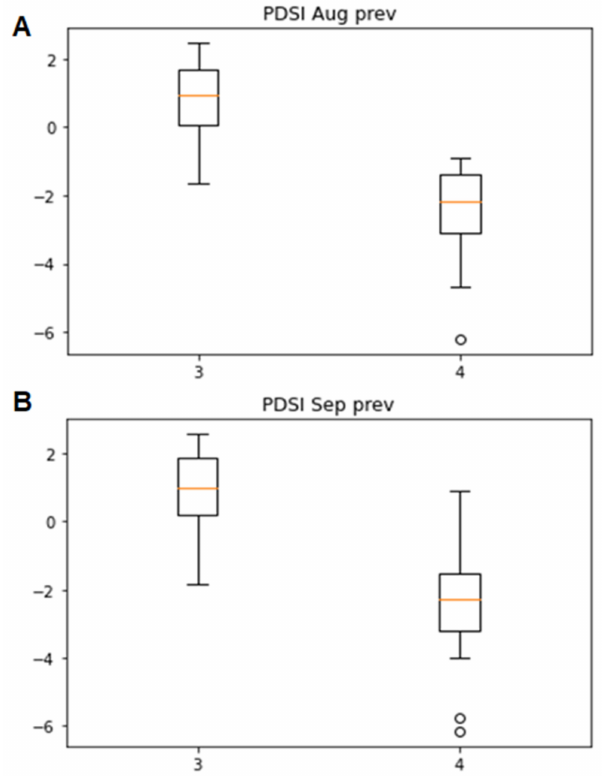
Figure 8. Box and Whisker plots for August ( A ) and September ( B ) scPDSI of the previous year corresponding to the third cluster and fourth cluster of tracheidograms: orange line—median; box—25% and 75% quartiles; whiskers—non-outlier minimum and maximum;